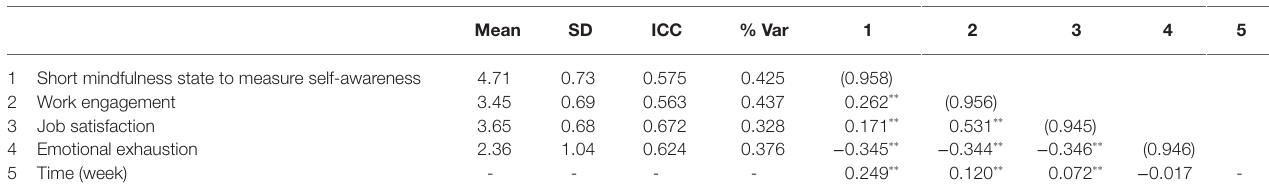
TABLE 1 | Mean, SD, reliability, and intercorrelation of study variables.